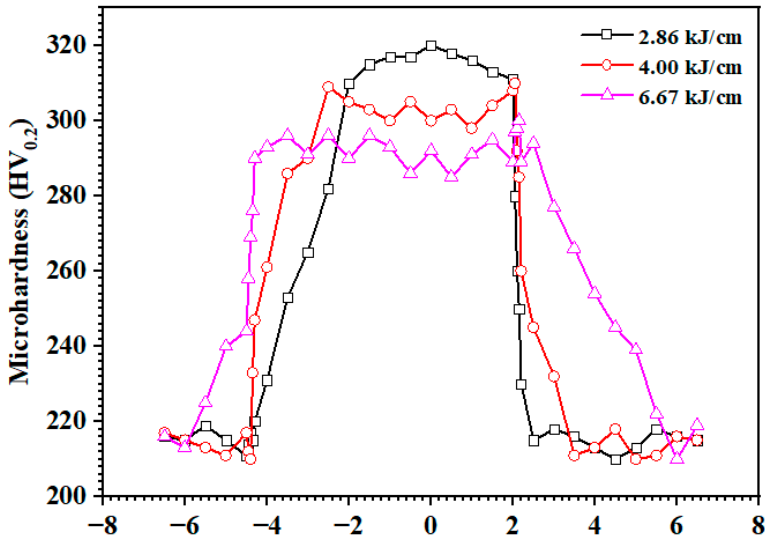
Figure 9. The microhardness of the welded joints with different heat inputs.